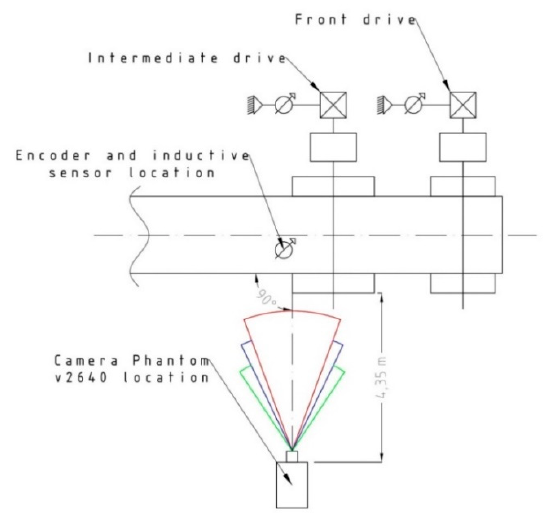
Figure 3. Positions of belt linear speed measurements on the intermediate drive test rig.